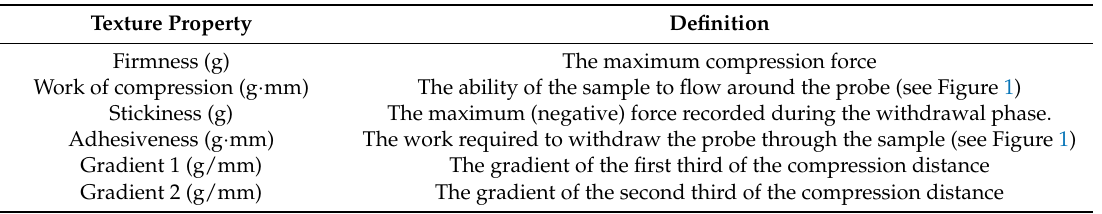
Table 4. Texture properties